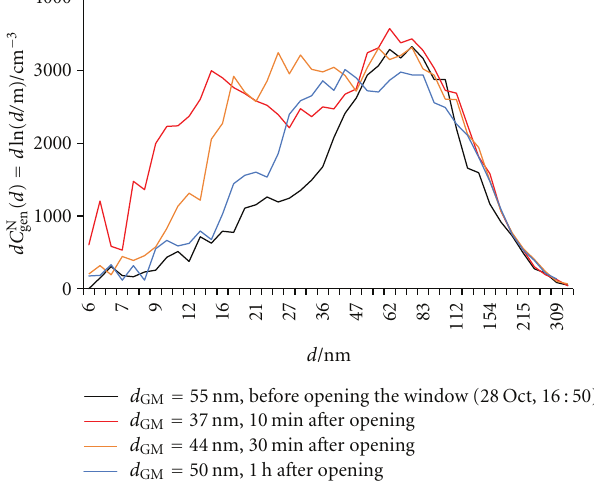
Figure 12: Number size distributions (d C N window in the